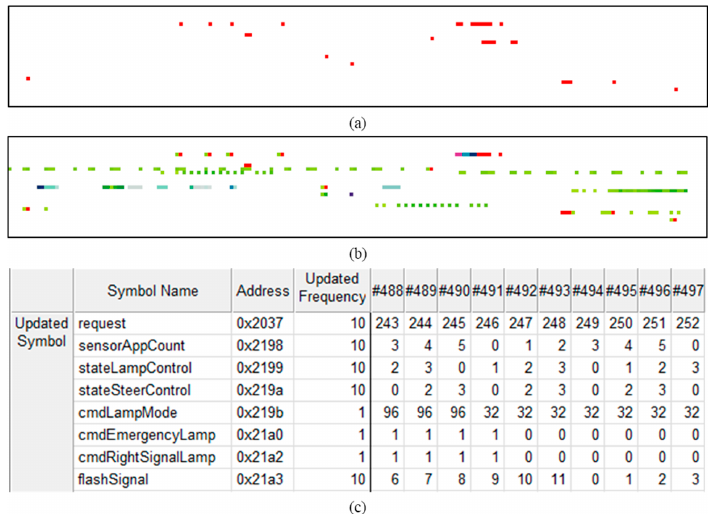
Figure 6. Example of Analyzed Memory Updated Information: ( a ) n-th frame; ( b ) Full Range of Frames; ( c ) MUI A, R (A = {a|MUF a, R > 0}, R = [488,497]).